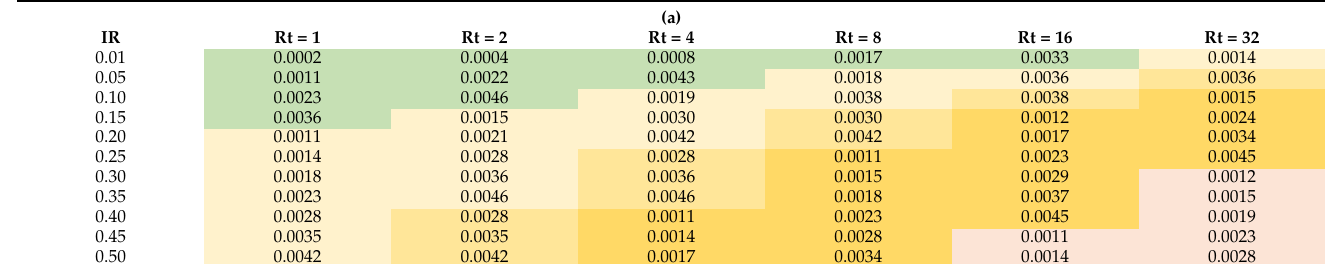
Table 4. Regardless of vaccine status, travelers’ expected transmission with negative preboarding, with/without arrival, with/without post-quarantine tests. ( a ) Expected transmission for travelers with a negative preboarding PCR test and a negative arrival test. ( b ) Expected transmission for trav- elers with a negative preboarding RPD * test and a negative arrival test. ( c ) Expected transmission for travelers with a negative preboarding RPD test and a negative arrival test. ( d ) Expected transmission for travelers with an invalid preboarding test and a negative arrival